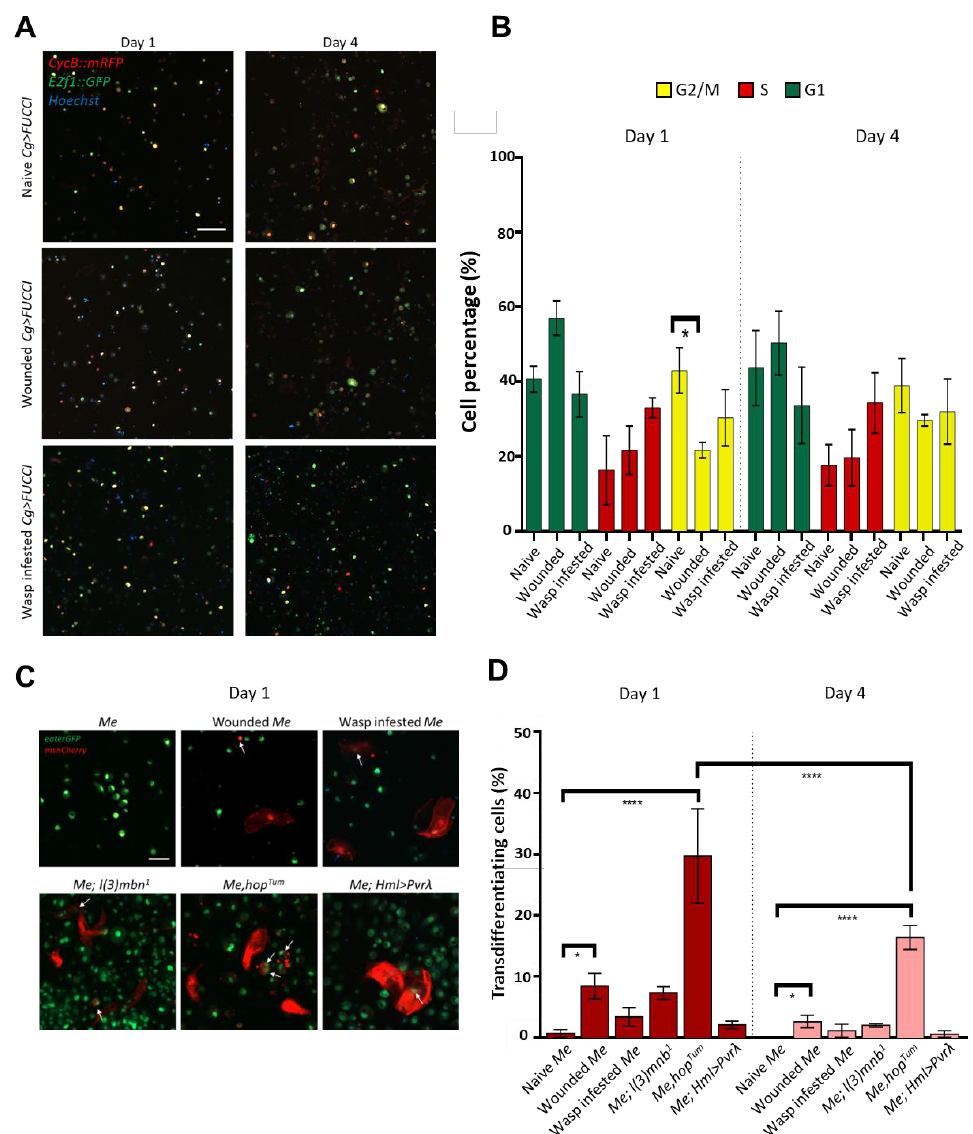
Figure 3. Proliferation and transdifferentiation in ex vivo hemocyte cultures. ( A ) Representative images of naive, wounded, and wasp-infested Cg > Fly-FUCCI cultures on Day 1 and Day 4 (green: cells in G1 phase, red: cells in S phase, yellow: cells in G2/M phase). Scale bar: 50 µ m. ( B ) Bar graph showing the percentage of cells in G1, S, and G2/M phase in hemocyte cultures derived from naive, wounded, and wasp-infested Cg > Fly-FUCCI larvae. Cells in three fields of view at a 10 × objective were counted from each sample (n = 3), and the data are the mean ± SD of three independent exper- iments. Data were analyzed using ANOVA with Tukey’s test for multiple comparisons, * p ≤ 0.05. ( C ) Representative images of hemocyte cultures of naive, wounded and wasp infested Me , and tumorous Me; l(3)mbn 1 , Me,hop Tum and Me; Hml>Pvr λ on Day 1 of culturing (green: plasmatocytes, red: lamellocytes), arrows indicate transdifferentiating cells expressing both eaterGFP and msnCherry . Scale bar: 20 µ m. ( D ) Bar graph showing the percentage of transdifferentiating cells (ratio of eaterGFP and msnCherry double positive cells to the total cell number in the culture) in naive, wounded, and wasp infested Me , and tumorous Me; l(3)mbn 1 , Me,hop Tum and Me; Hml>Pvr λ on Day 1 and Day 4 of culturing. Cells in three fields of view at a 10x objective were counted from each sample (n = 3), and the data are the mean ± SD of three independent experiments. Data were analyzed using ANOVA with Tukey’s test for multiple comparisons, * p ≤ 0.05, **** p ≤